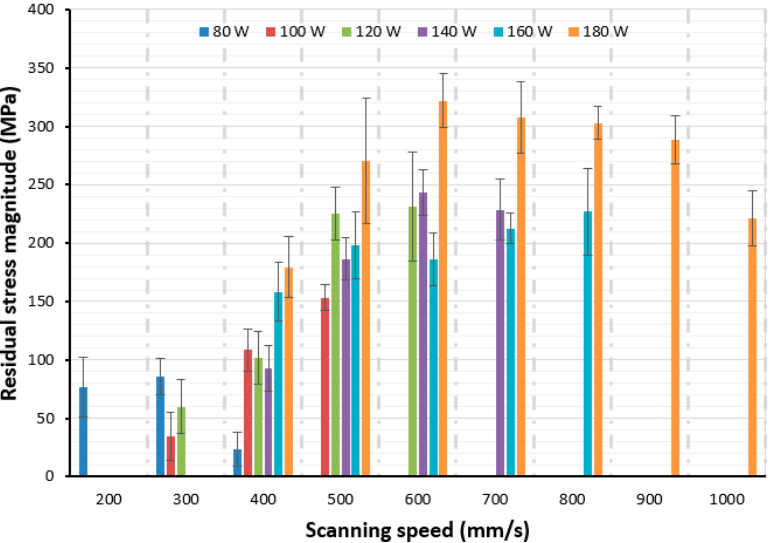
Figure 7. Variation of residual stress magnitude with laser power and scanning speed (30-µm layer).